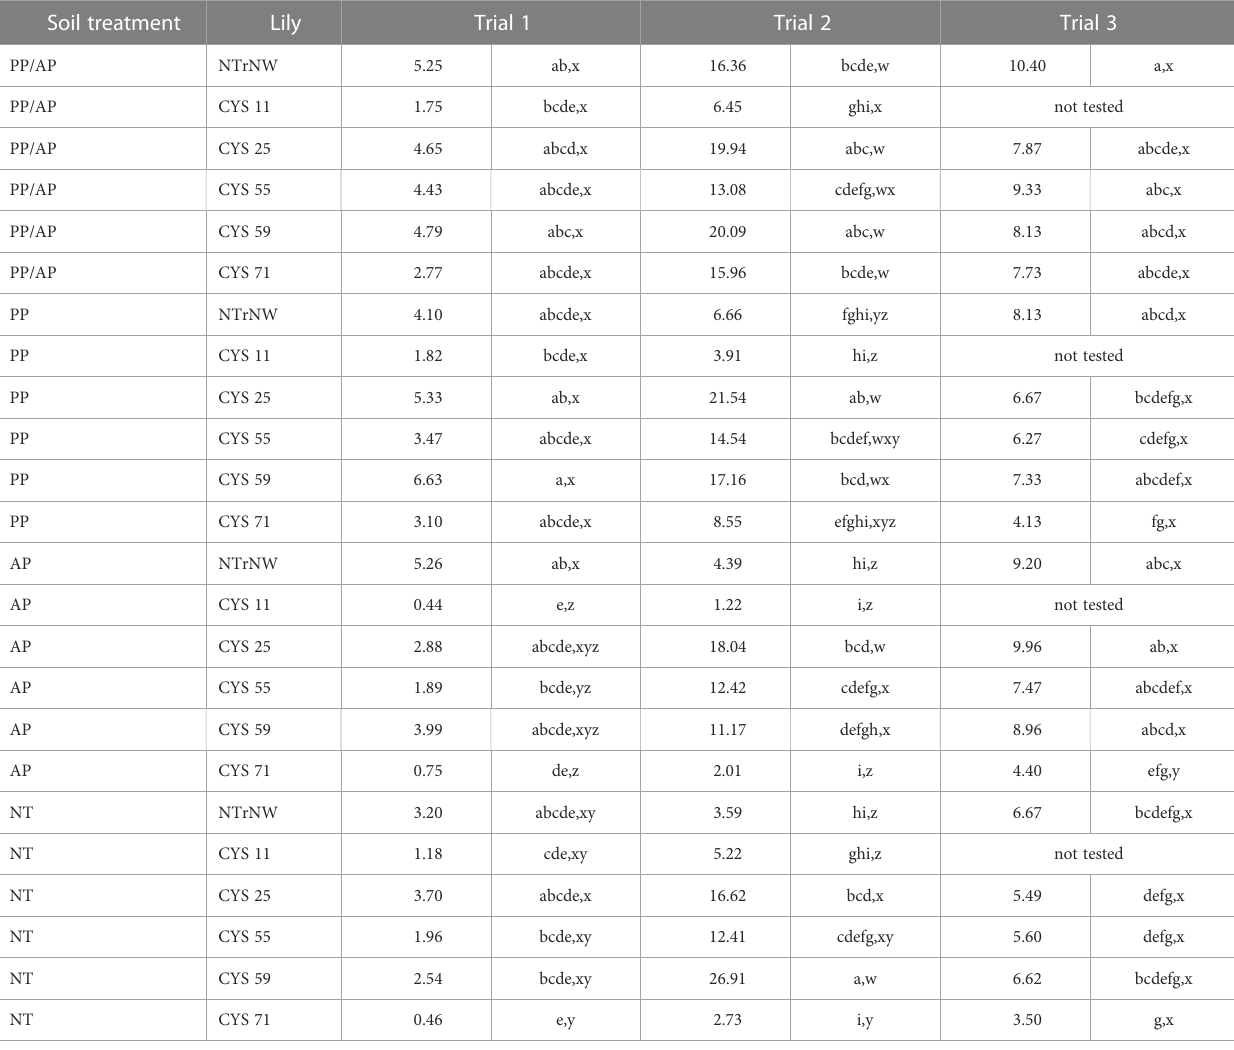
TABLE 4 Weight of basal roots (grams) per plant at harvest in fi eld trials conducted at the Easter Lily Research Foundation Research Station in Brookings, OR, USA in soil naturally infested with lesion nematode ( Pratylenchus penetrans ). Soil treatment